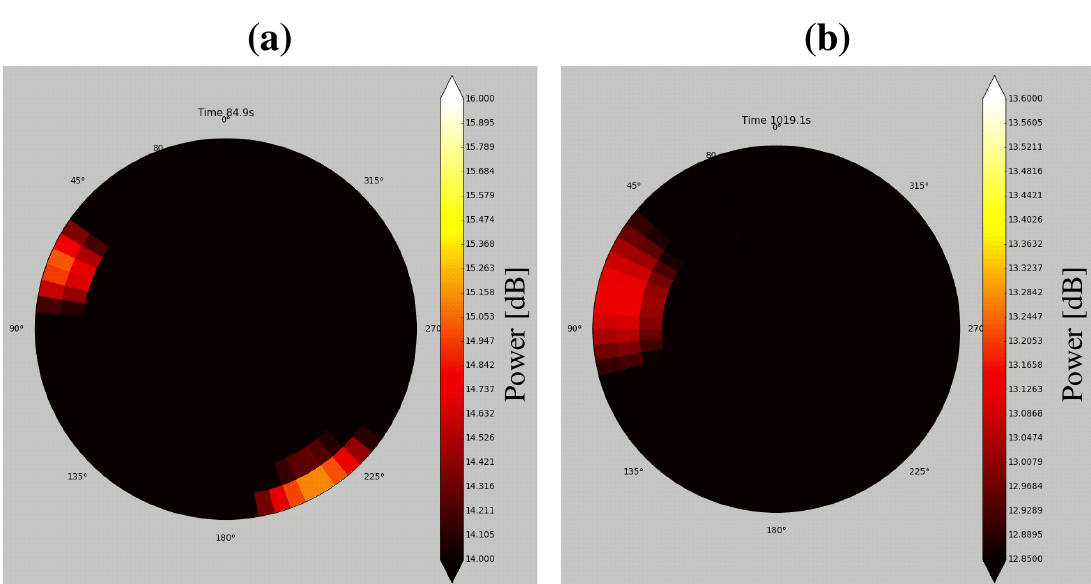
Figure 11. MUSIC spectra. ( a ) SEVD-MUSIC (MUSIC based on Standard Eigen Value Decomposition); ( b ) iGSVD-MUSIC (MUSIC based on incremental generalized singular value decomposition).